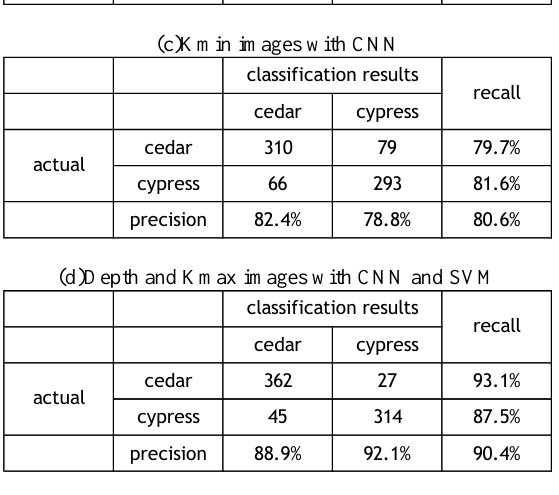
(b) Kmax images with CNN